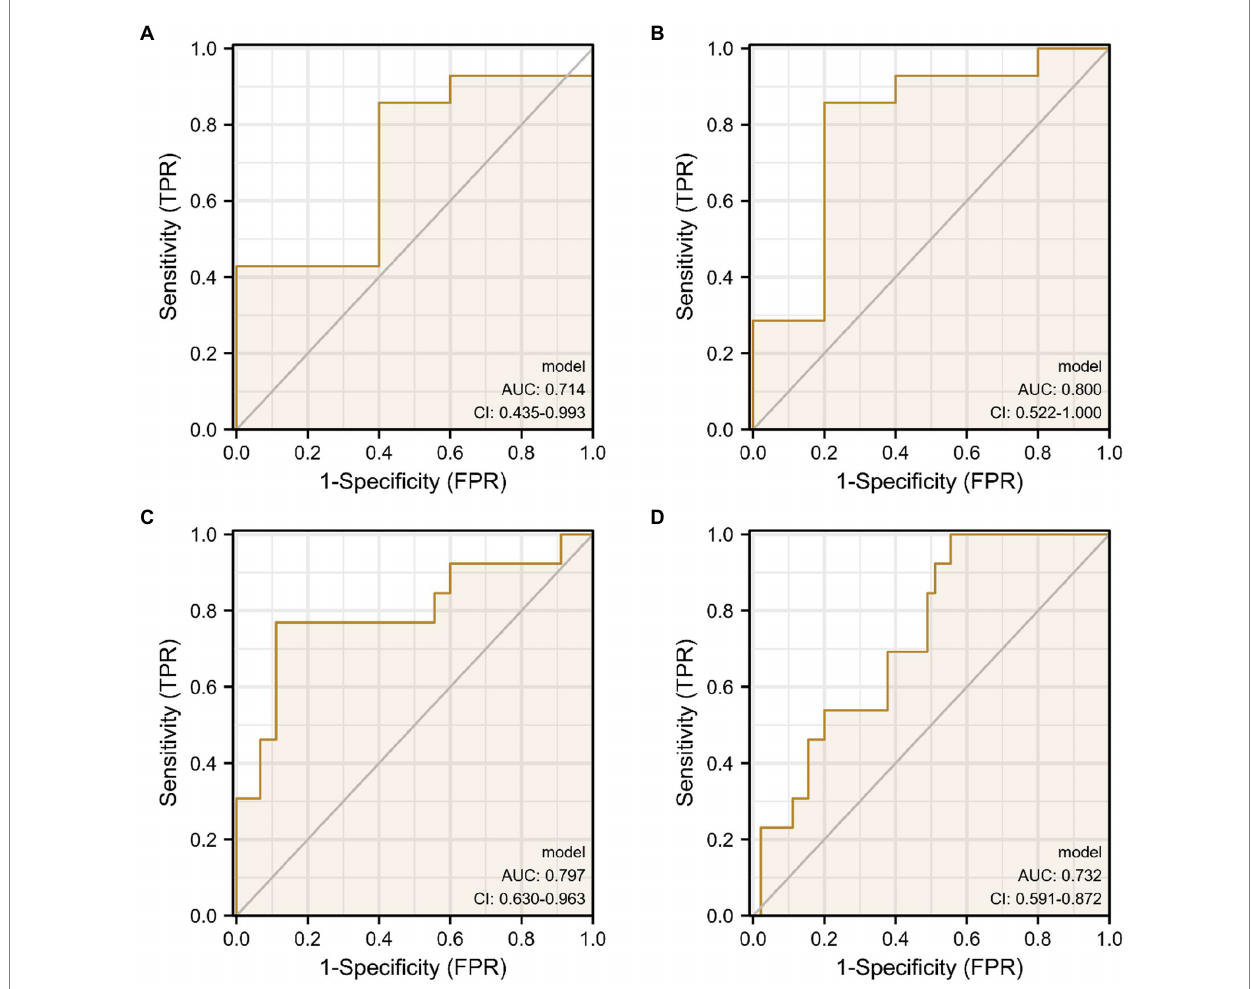
FIGURE 12 ROC curves obtained from the diagnostic models of AD and MCI constructed using Top ROIs and genes of AD and MCI groups, respectively. (A,B) Are the diagnostic models of AD constructed using the Top features of the AD group, respectively. (C,D) Are the diagnostic models of MCI constructed using the Top features of the MCI group, respectively.